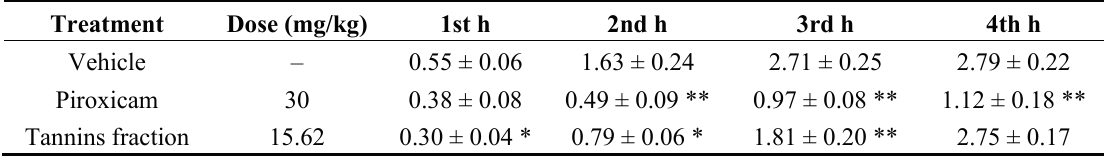
Table 3. Effects of administration of tannins fraction from Davilla elliptica leaves via the intraperitoneal route on carrageenan-induced rat paw oedema. Treatment Dose (mg/kg) 1st h 2nd h 3rd h 4th h Vehicle – 0.55 ± 0.06 1.63 ± 0.24 2.71 ± 0.25 2.79 ± 0.22 Piroxicam 30 0.38 ± 0.08 0.49 ± 0.09 ** 0.97 ± 0.08 ** 1.12 ± 0.18 ** Tannins fraction 15.62 0.30 ± 0.04 * 0.79 ± 0.06 * 1.81 ± 0.20 ** 2.75 ±